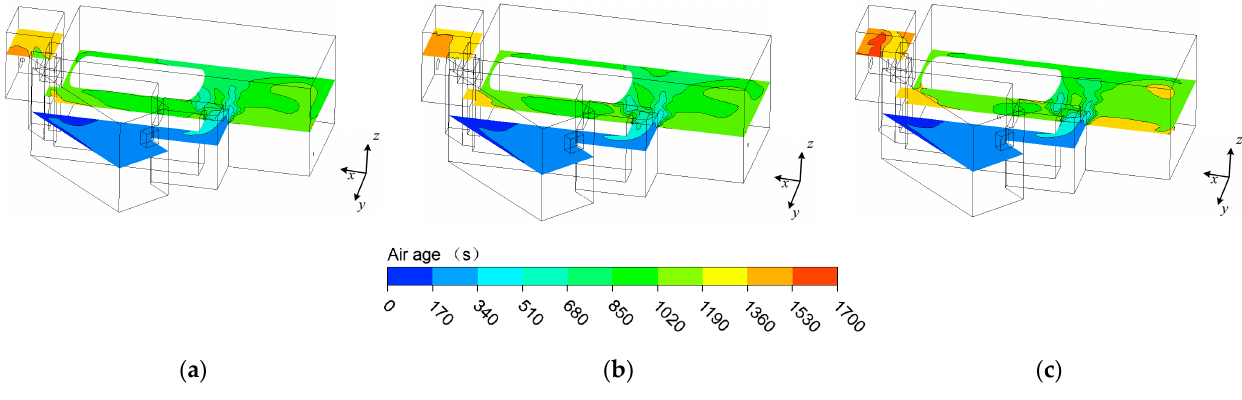
Figure 10. Air age contour of the same cross height section at three outlet heights (The scattering room z = 1.6 m and the sample room z = 2.4 m). ( a ) Air age of layout scheme 12. ( b ) Air age of layout scheme 13. ( c ) Air age of layout scheme 14. scheme 13. ( c ) Air age of layout scheme